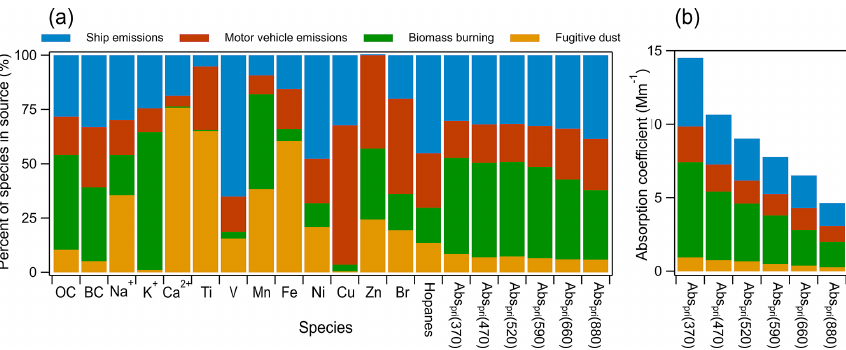
Figure 4. (a) Contributions of the four sources to each species from the positive matrix factorization model and (b) the light absorption of primary aerosols from each source at different wavelengths (Abs pri (λ) , λ = 370, 470, 520, 590, 660 and 880nm) during the study.